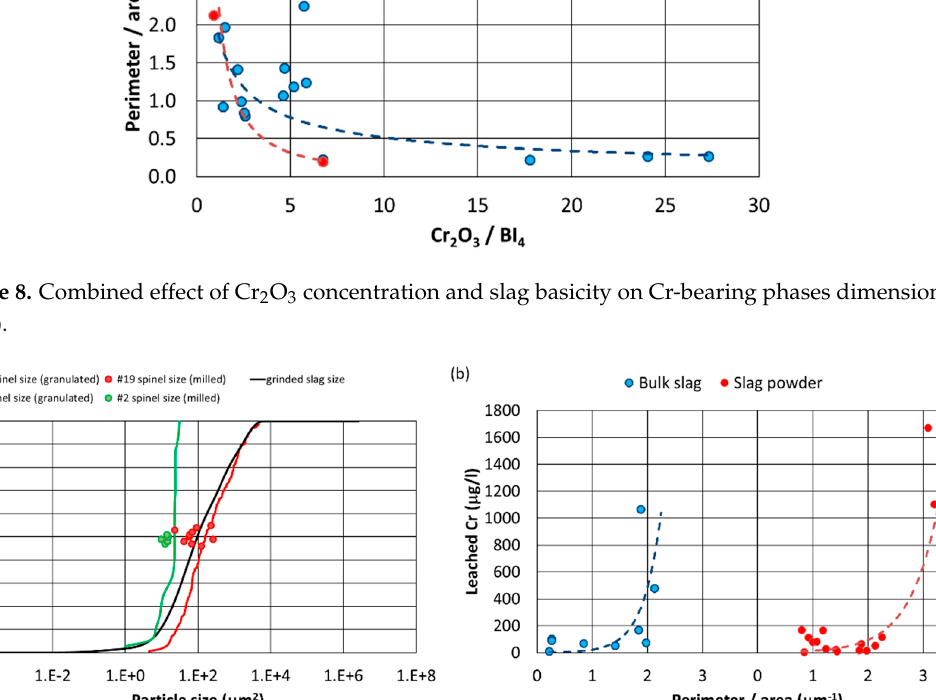
Figure 9. Comparison between milled particle size distribution and spinel size distribution ( a ) and role of phase dimension (p/A ratio) ( b ) on Cr leaching.